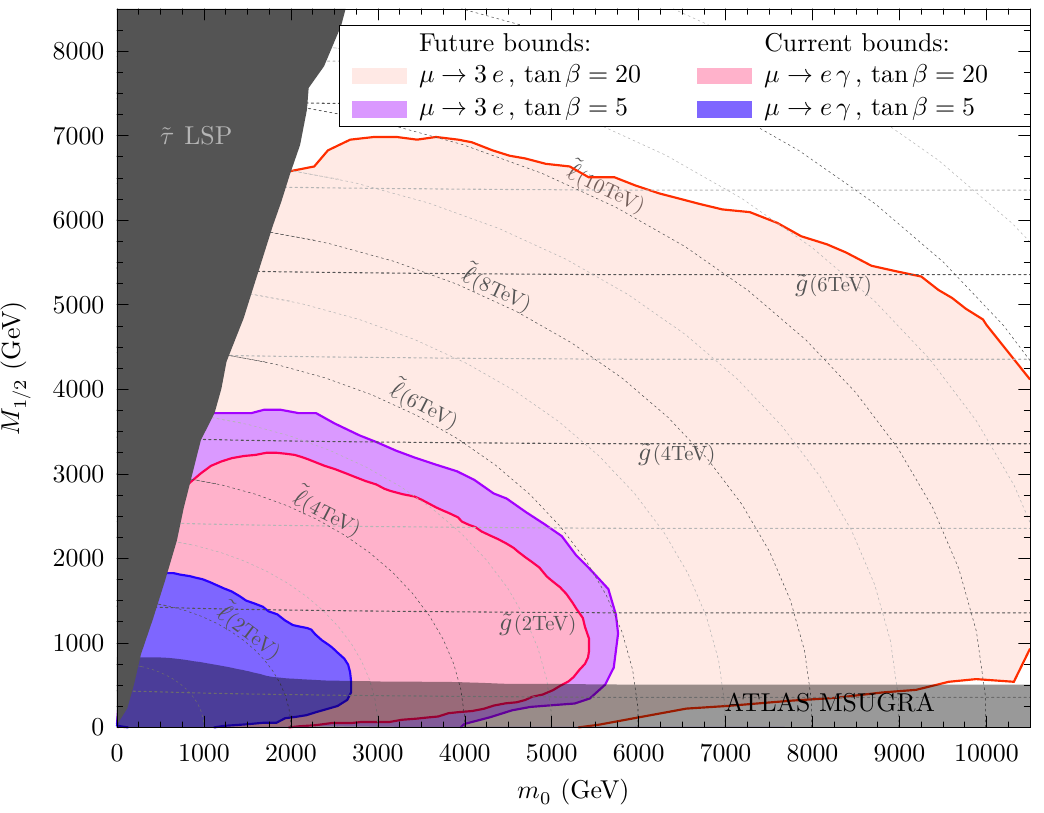
Figure 8 . Excluded regions due to (cid:22) ! e(cid:13) and (cid:22) ! eee for two reference values: tan (cid:12) = 5 (blue shapes) and tan (cid:12) = 20 (red shapes). In the dark (blue and red) regions, we compare with current (cid:22) ! e(cid:13) bounds while in the light (blue and red) regions we compare with the expected (cid:22) ! eee sensitivity in the near